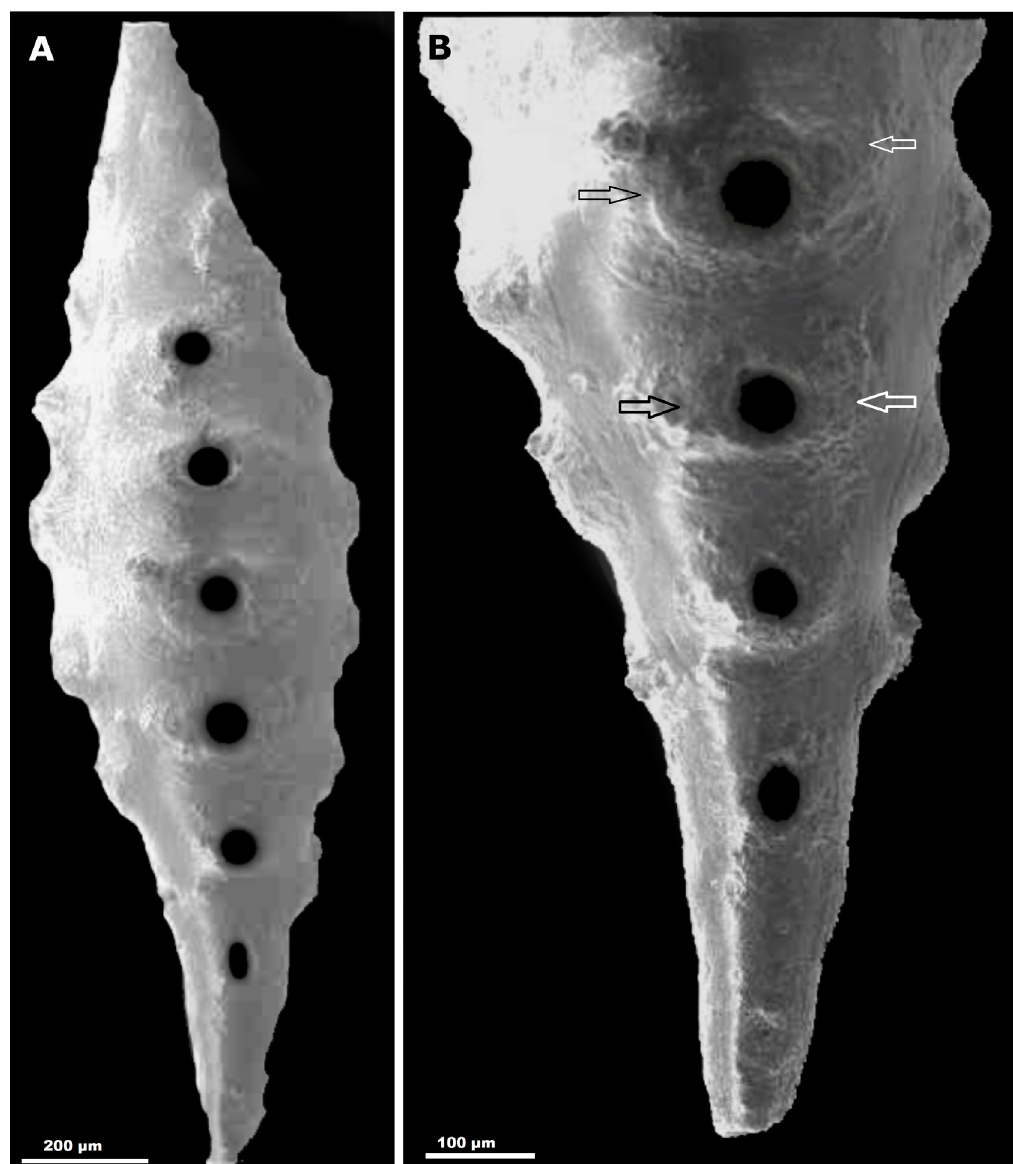
Fig. 12. Skylonia sandbergi Sandberg, 1962 (GIS/B 0549). A . General view of the colony showing autozooids and well-developed knobs bordering the aperture. B . Close-up of the colony showing autozooids and well-developed knobs